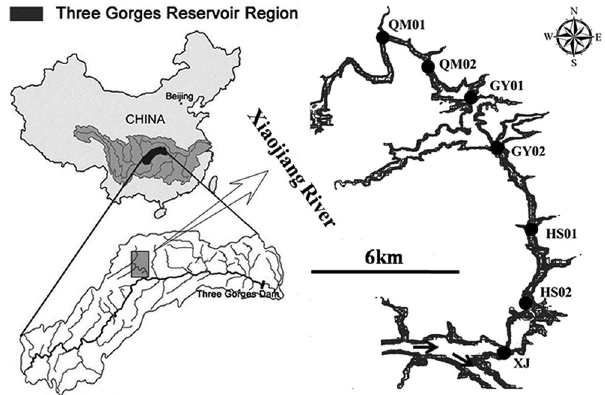
Figure 8. Maps of the location of the Three Gorges Reservoir Region, and the sampling sites in the Xiaojiang River (Created by Arcmap